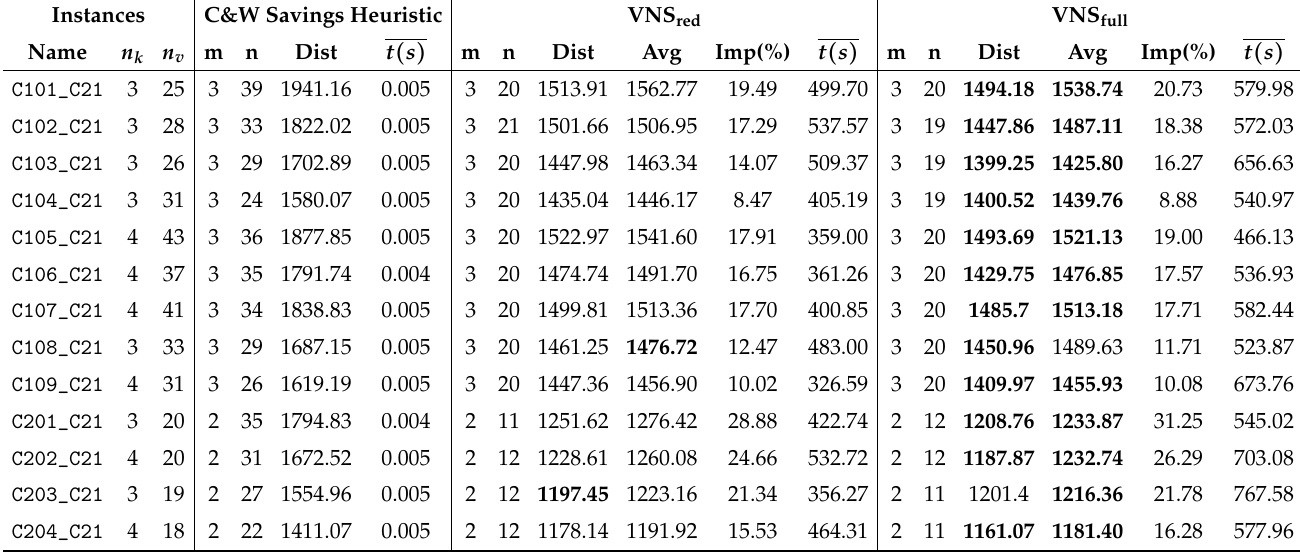
Table 8. Computational results for large-sized clustered